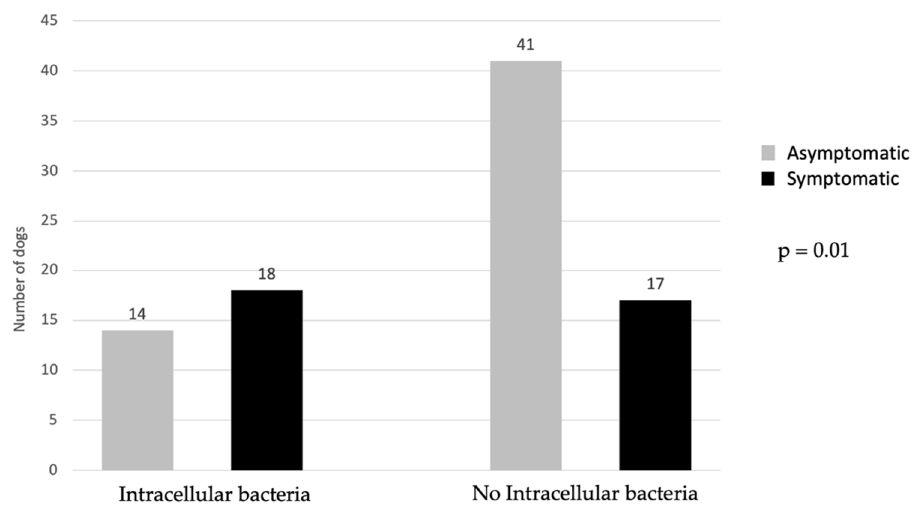
Figure 3. Total bacterial count did not differ significantly between symptomatic ( n = 19) and asymptomatic ( n = 19) dogs (Figure 4).